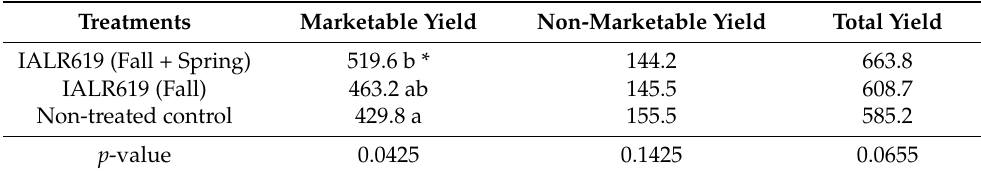
Table 3. Effects of bacterial application on strawberry